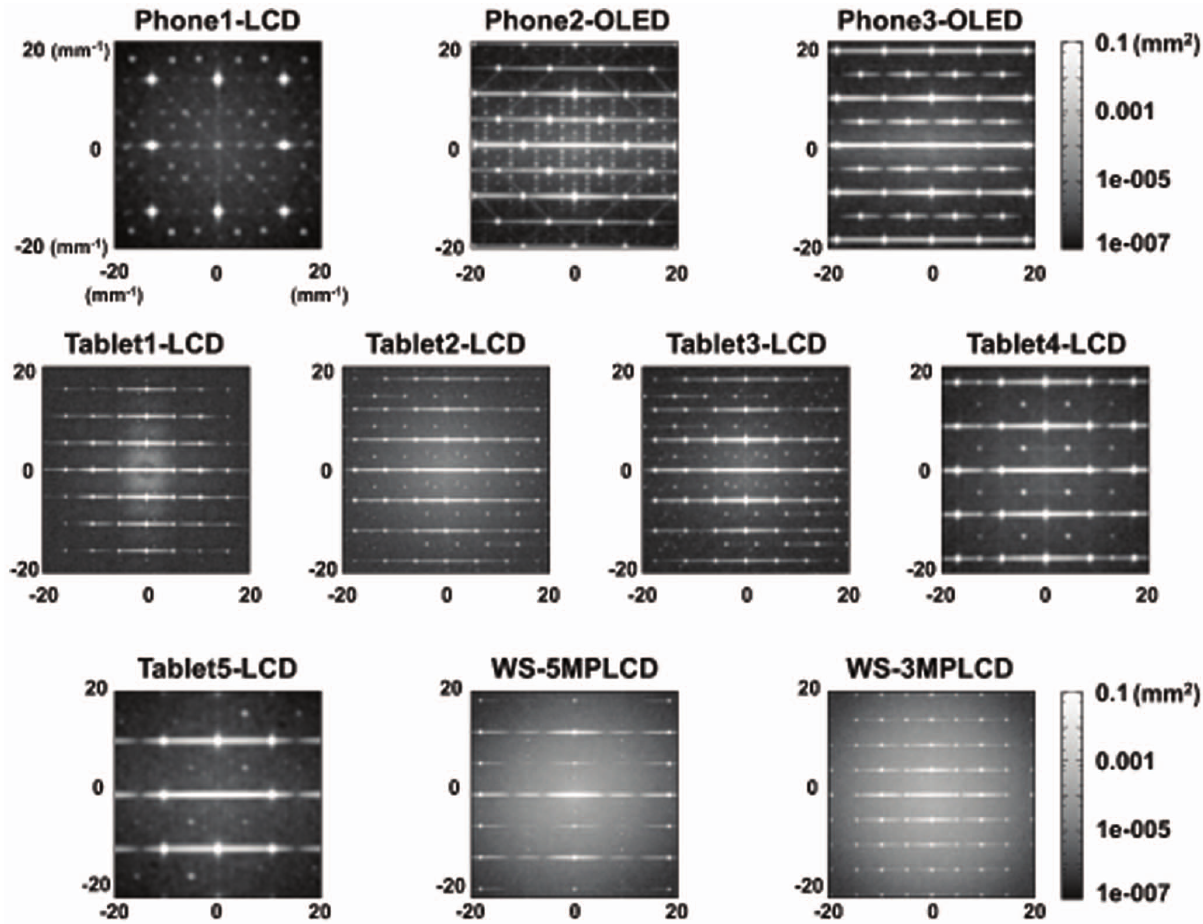
Figure 8. Two-dimensional noise power spectra for the devices tested in this study.